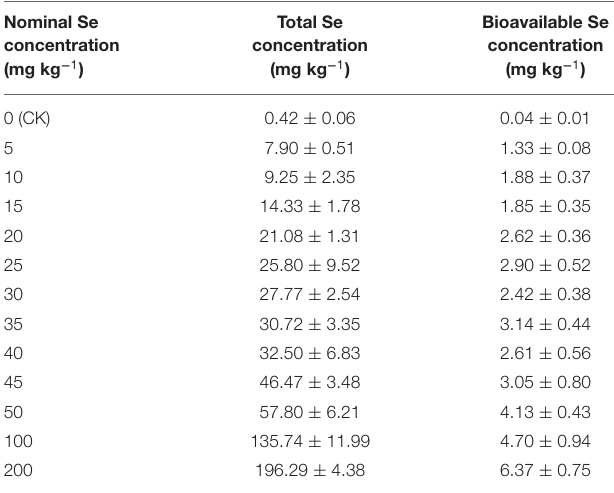
TABLE 2 | Total and bioavailable Se concentration (dry weight) in the soil after plant